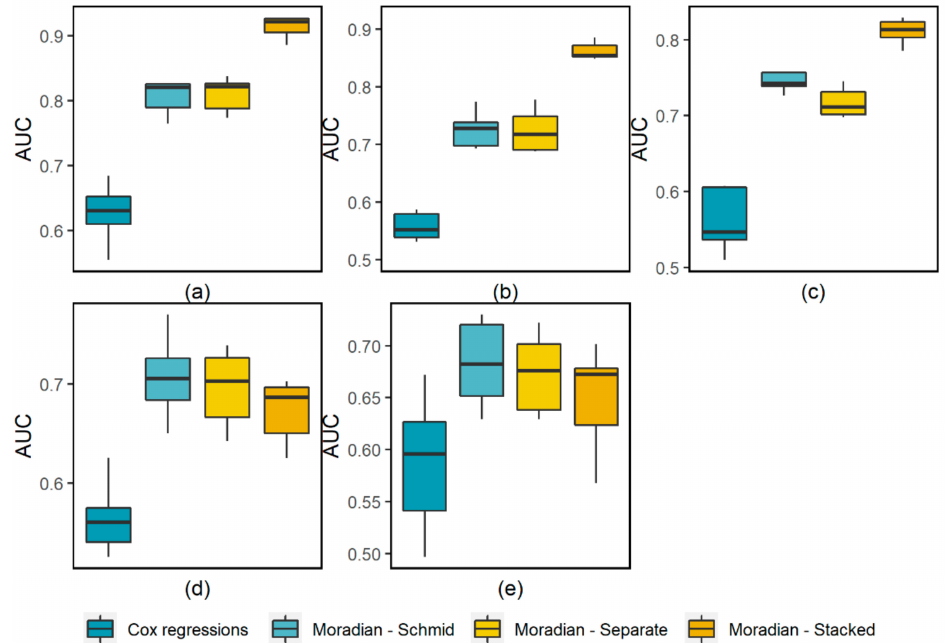
Figure 2. AUC comparison of simulated Cox regressions and random forests (N = 500) when t = 1: ( a ) AUC comparison for t = 1, u = 2; ( b ) AUC comparison for t = 1, u = 3; ( c ) AUC comparison for t = 1, u = 4; ( d ) AUC comparison for t = 1, u = 5; ( e ) AUC comparison for t = 1, u = 6.